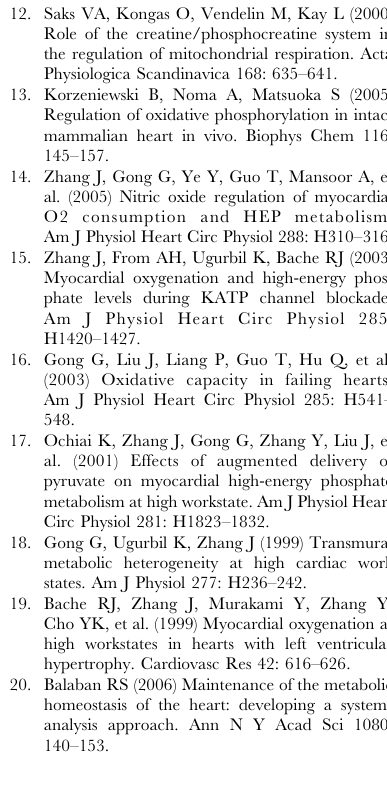
Figure 3 when all metabolites are independently diffusing. In fact, while restricted diffusion of ADP and ATP and catalytic coupling of ANT and mtCK would tend to enhance the role of